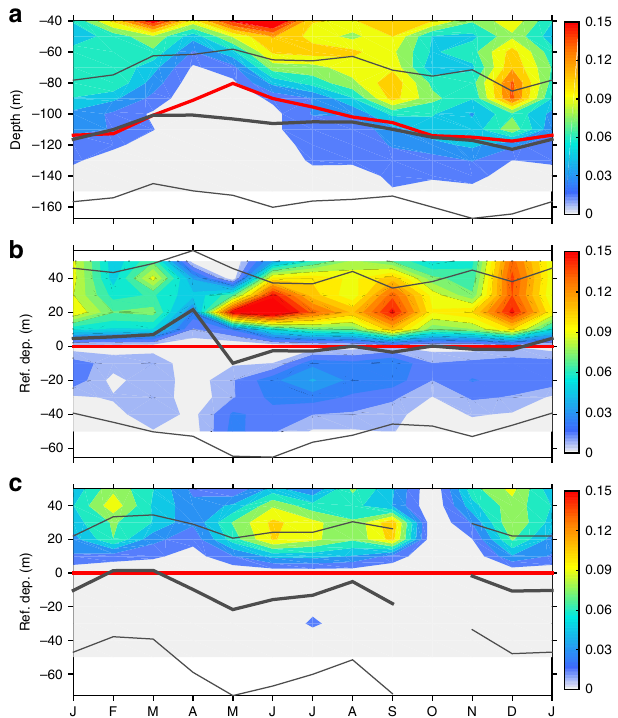
Figure 5 | Monthly climatology of occurrence probability of critical levels at 140 (cid:2) W of the Equator. ( a ) On physical depths. ( b ) For periods of TIWs but on the depth that is referenced to instantons EUC cores (see caption of Fig. 4). ( c ) The same as in b , but for periods of non-TIWs. TIW (non-TIW) periods are defined when the TIW KE is larger (less) than 0.04m 2 s (cid:3) 2 . The occurrence probability is defined as the ratio of the number of unstable modes over the number of profiles in 10-m bins. The red curve denotes the average depth of EUC core, the black thick curve denotes the average depth of the thermocline centre and the black thin curves denote the average depths of the thermocline bounds.